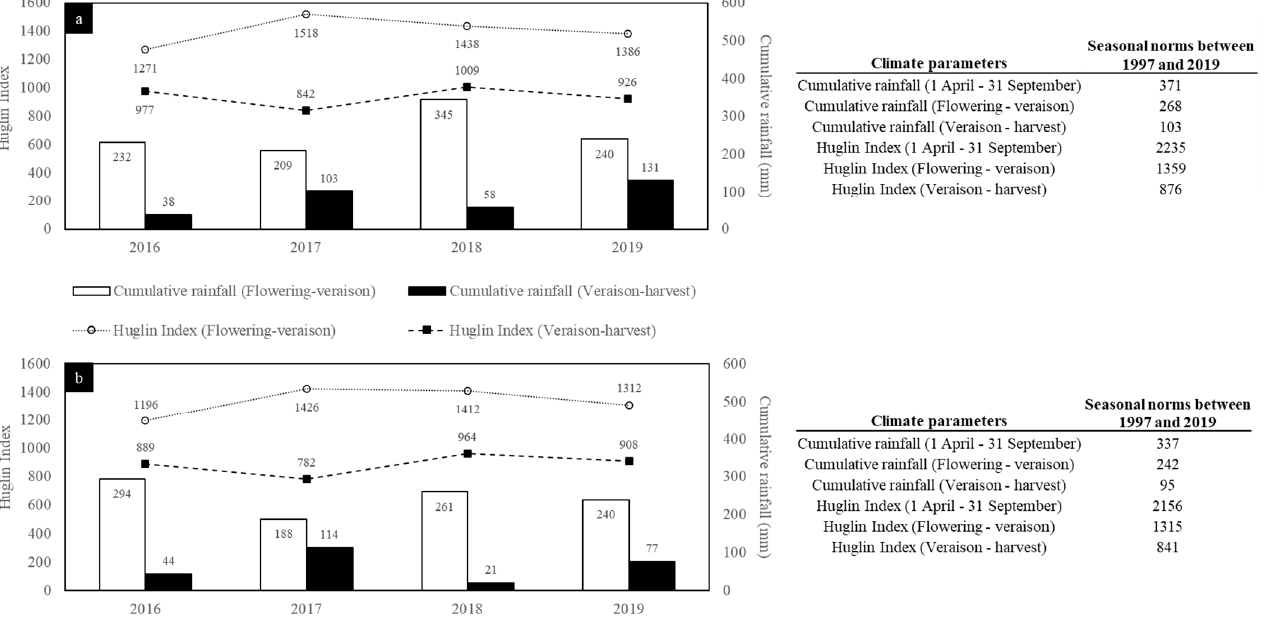
Figure 2. Climatic conditions observed in the Gers ( a ) and Tarn ( b )